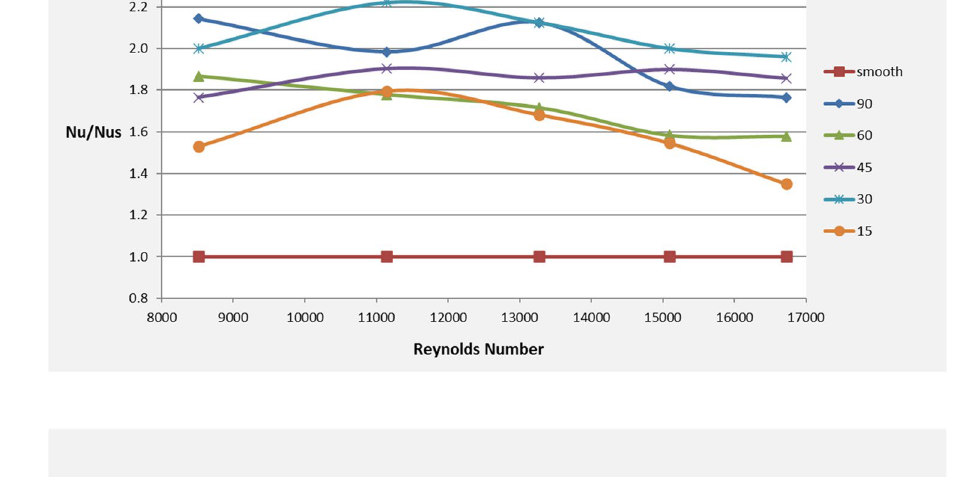
Fig. 6 Variation of f/fs with Reynolds Number at P/D =